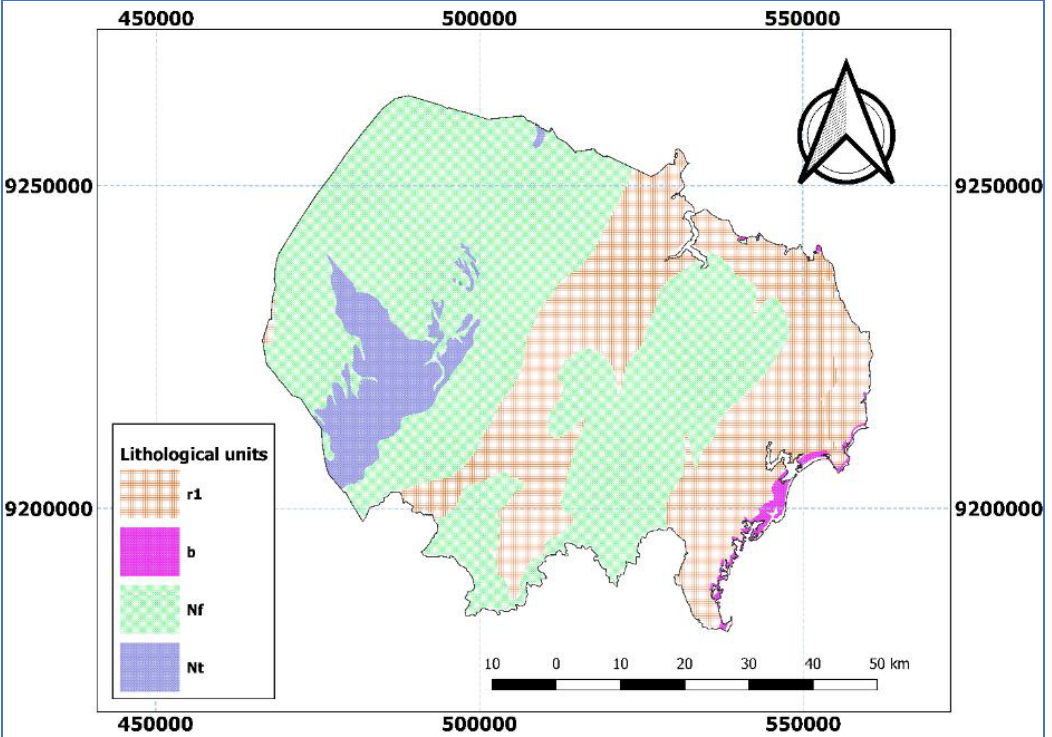
Figure 3. The geology of the Kimbiji aquifer.